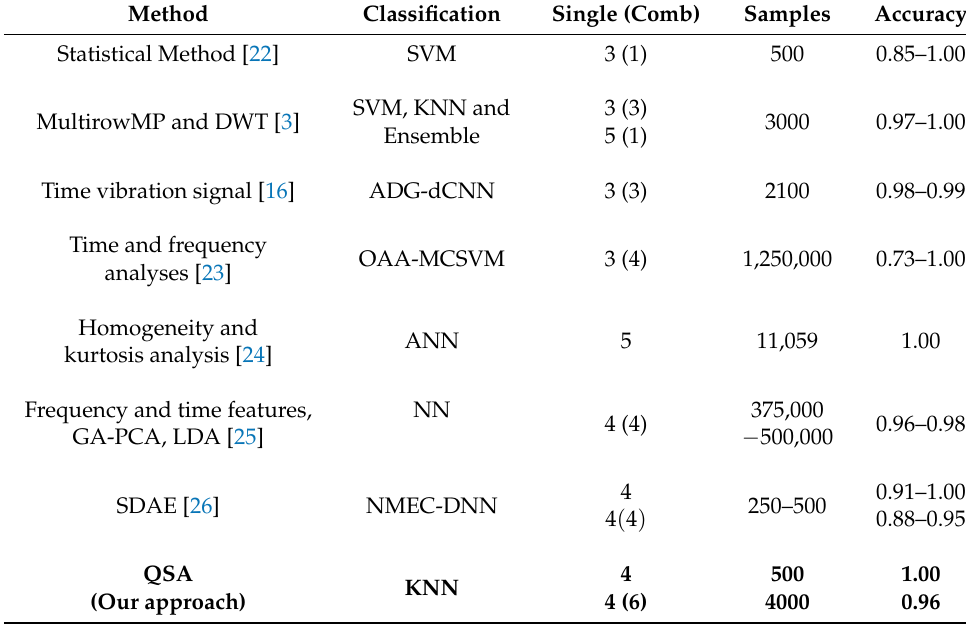
Table 3. Methods comparison table involving the proposed